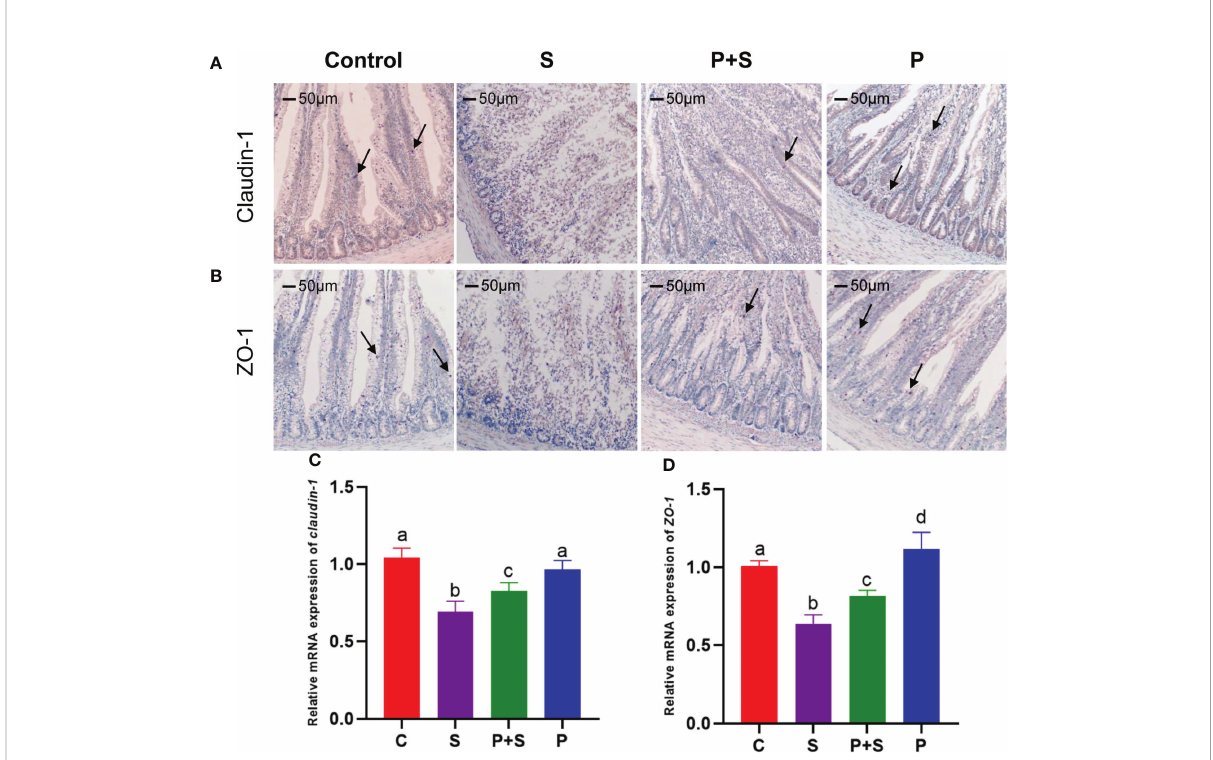
FIGURE 4 Immunohistochemical staining sections of tight junction and the relative genes expression. Immunohistochemical staining was used to identify the presence of tight junction proteins (A) claudin-1 and (B) ZO-1 in intestinal tissues, and RT-qPCR was used to detect (C, D) the relative mRNA expression of tight junction protein genes. The arrow in the fi gure refers to a part of the stained tight junction protein. a, b, c, d: indicated the same item with different letters differ signi fi cantly ( P <